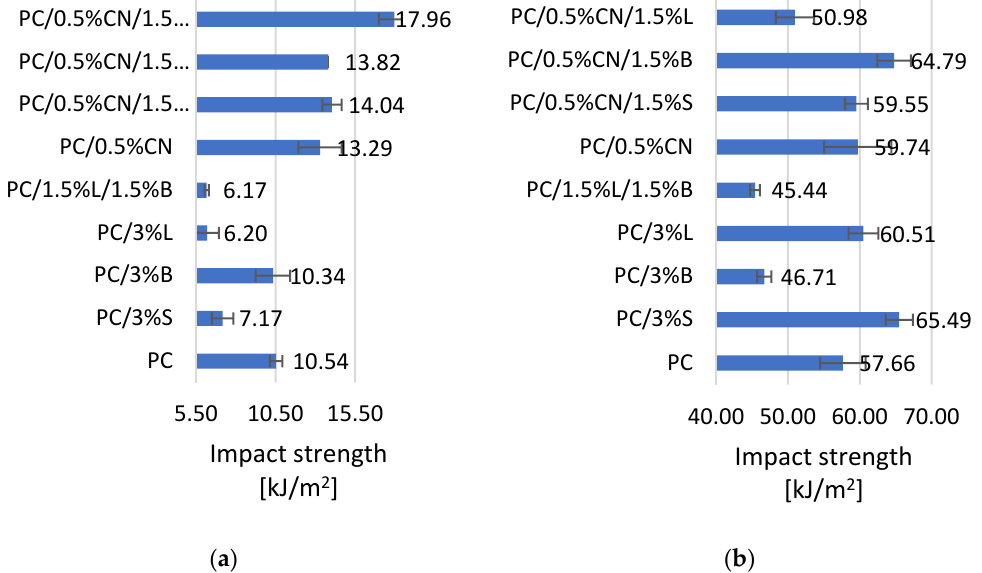
Figure 7. Impact test results of ( a ) samples obtained by 3D printing, ( b ) samples obtained by injection molding.